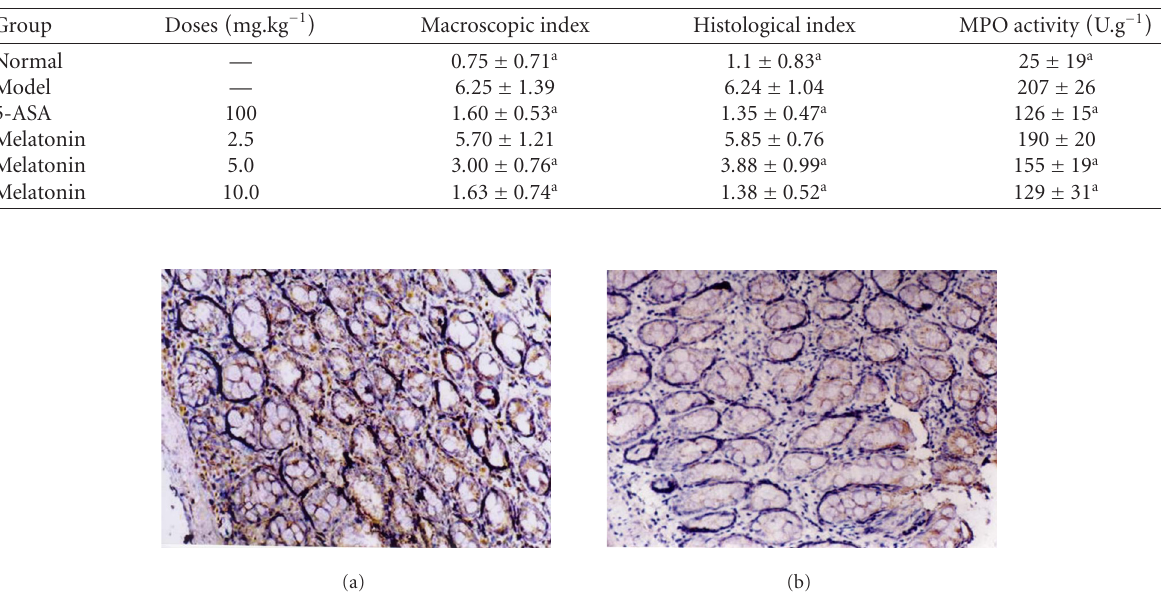
Figure 1. Immunohistochemical staining of RelA in colon tissues of (a) model rats and (b) rats with melatonin treatment (10mg.kg − 1 ). SP × 200. RelA protein is mainly expressed in the nucleus and cytoplasmic accumulation of RelA is also detected. RelA expression decreases dramatically in melatonin